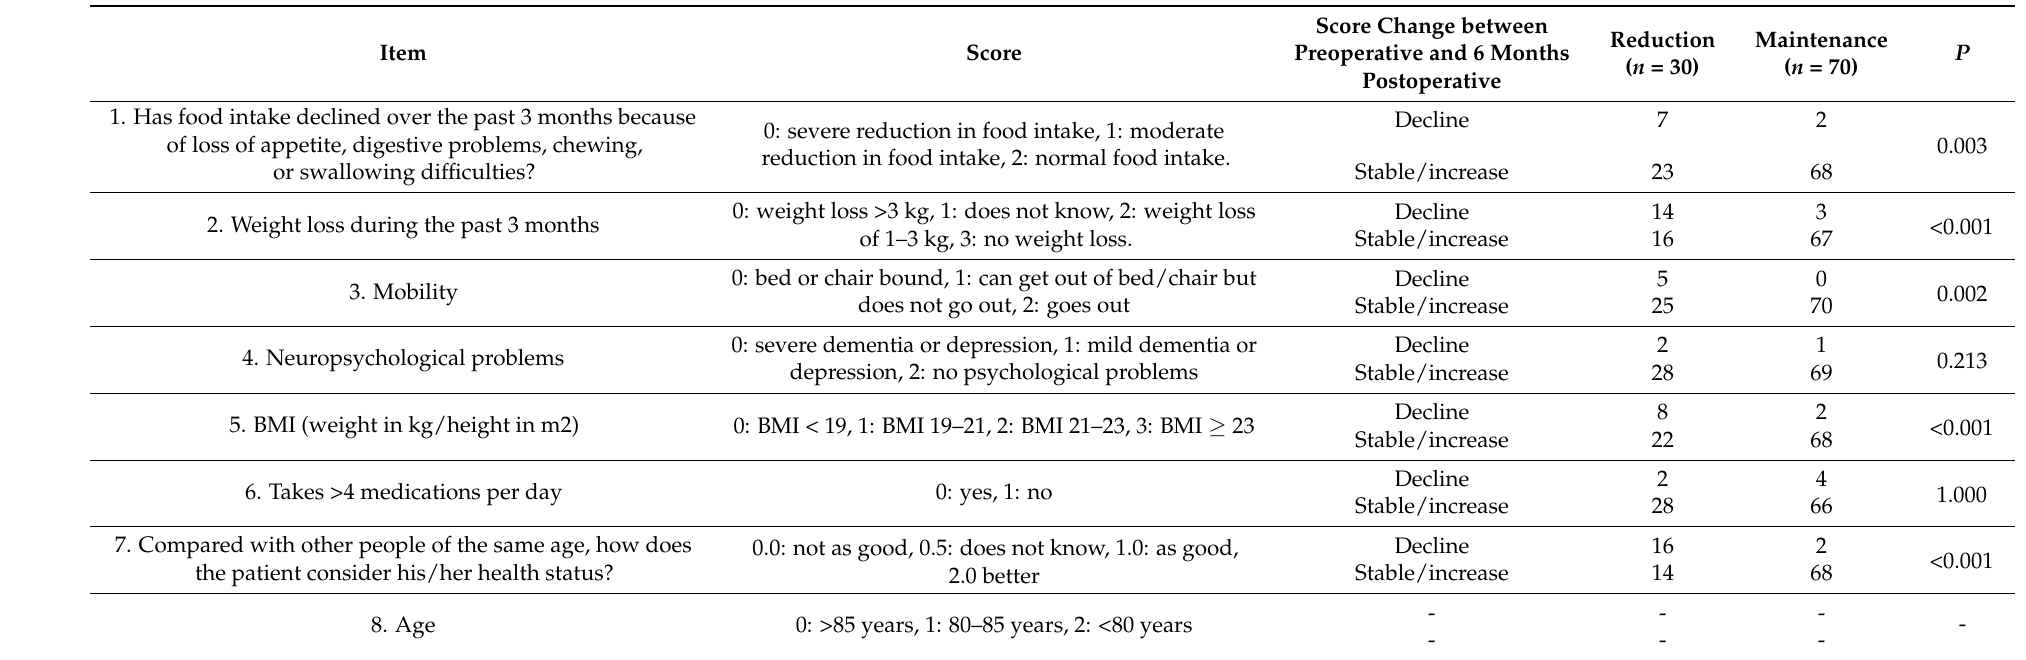
Table 4. Score change in each of the eight G8 items between